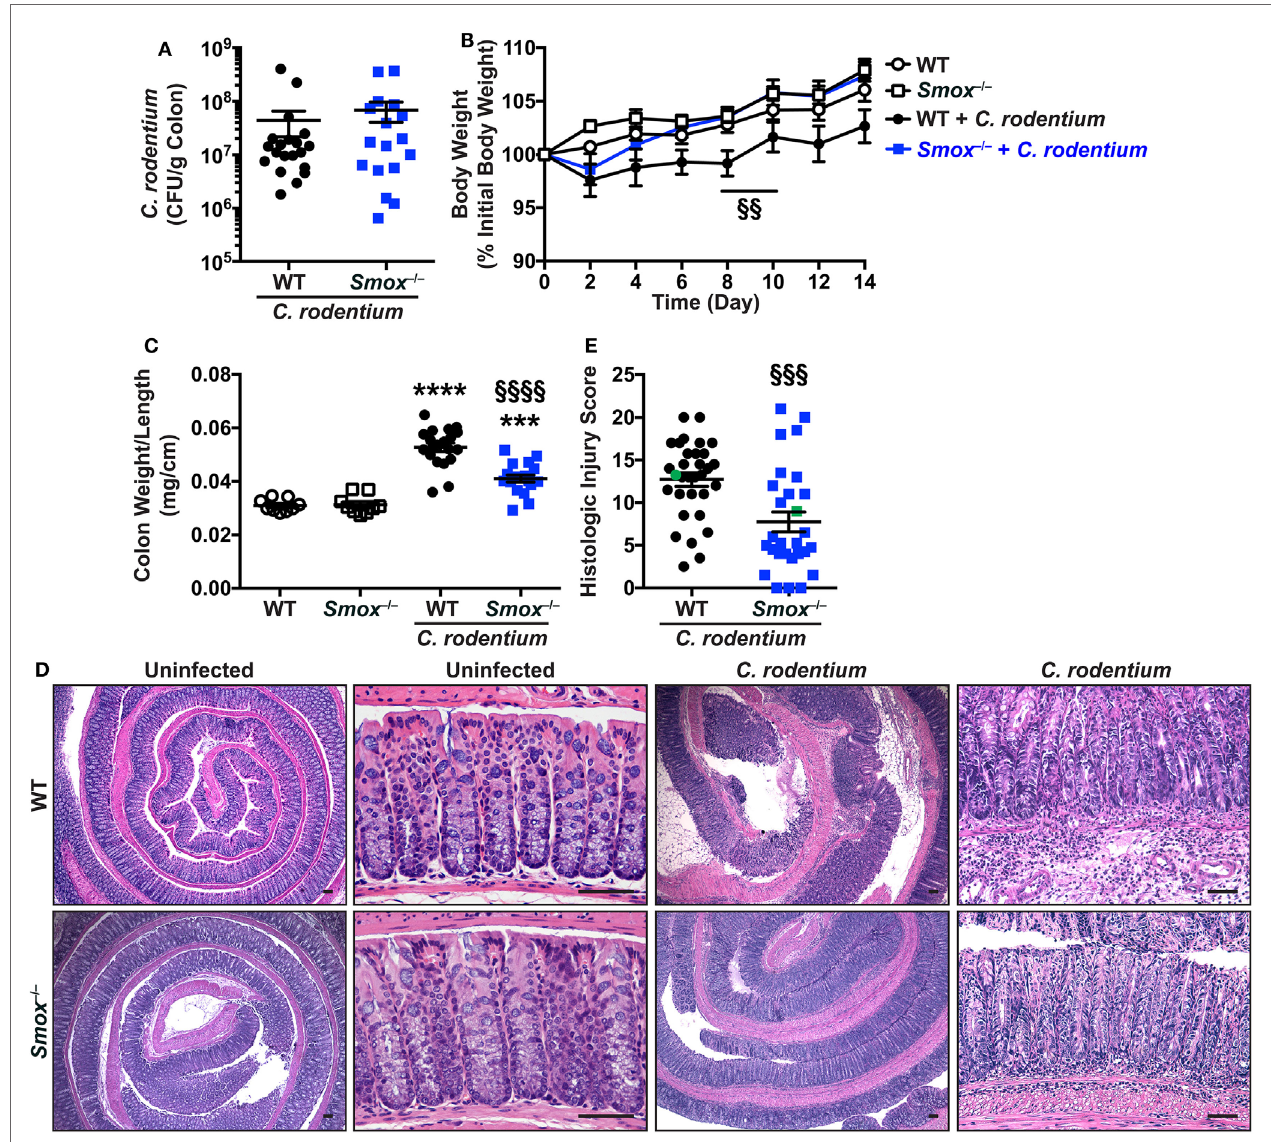
FigUre 1 | Effect of Smox deletion on Citrobacter rodentium colitis. C57BL/6 or Smox − / − mice were infected with C . rodentium . (a) After 14 days, C. rodentium colonization in the colon was assessed by plating serial dilutions. (B) Body weights were measured every 2 days and are presented as percentage of initial body weight. (c) Colons were harvested, measured, washed, and weighed. (D,e) Colons were Swiss­rolled and stained with hematoxylin and eosin (D) and scored for histologic injury (e) . The histologic injury score of uninfected wild­type (WT) and Smox − / − mice was 0 for both. In panel (e) , the green points represent the animals depicted in panel (D) . Scale bar, 50 µm. For panels (B,c,e) , *** P < 0.001 and **** P < 0.0001 compared with uninfected animals; §§ P < 0.01, §§§ P < 0.001, and §§§§ P < 0.0001 for Smox − / − mice versus WT mice infected with C. rodentium . Each point represents a mouse. In panel (B) , N = 8 uninfected and 15 infected mice for each genotype of